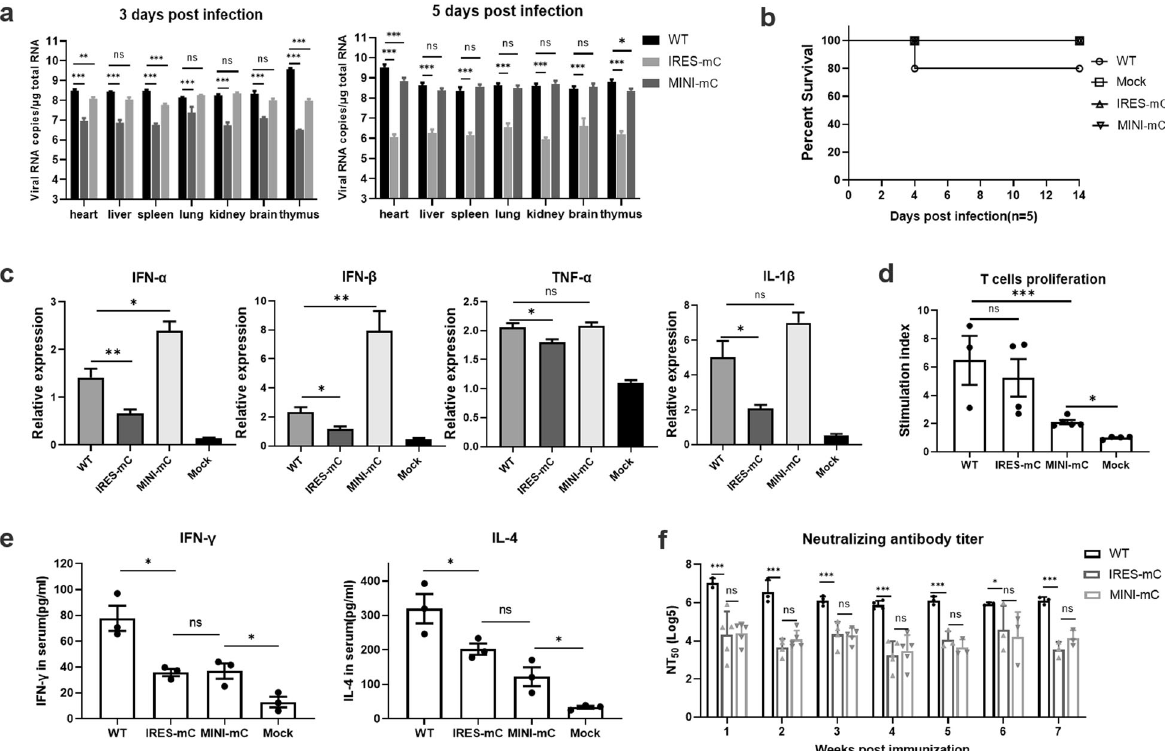
Fig. 4 Immune responses stimulated by the CQW1-IRES-mC and CQW1-MINI-mC viruses. Twenty- fi ve-day-old ducks were infected with the WT virus, CQW1-IRES-mC, or CQW1-MINI-mC virus at a dose of 10 5 TCID 50 . The mock group was treated with DMEM. a The vRNA loads in the heart, liver, spleen, lung, kidney, brain and thymus of the ducks at 3 and 5 dpi were detected by RT – qPCR ( n = 3). b Survival rate of 25-day-old ducks after infection ( n = 5). c The relative mRNA expression of IFN- α , IFN- β , TNF- α , and IL-1 β in the spleen was detected at 5 dpi ( n = 3). d Duck peripheral T-lymphocyte proliferative response to TMUV infection. At 14 dpi, blood T lymphocytes were isolated and cultured in vitro and then speci fi cally stimulated to proliferate by TMUV or puri fi ed recombinant truncated E protein. After 36 h of cell culture at 37 °C, cell proliferation was detected using a CCK-8 kit. e At 14 dpi, the serum levels of IFN- γ and IL-4 in the ducks were determined by ELISA. f The neutralization antibody levels in the serum were determined by PRNT. The data are presented as the means and SEMs; signi fi cance was de fi ned by * p < 0.05; ** p < 0.01; *** p < 0.001, and ns indicates no signi fi